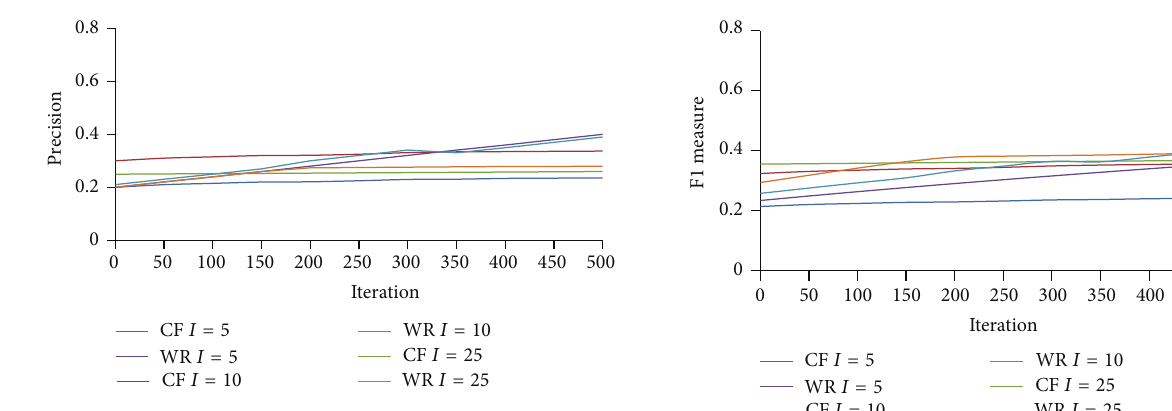
Figure 6: WebBluegillRecom-annealing system (WR) is compared to standard collaborative filtering (CF) system on precision, 248 users.